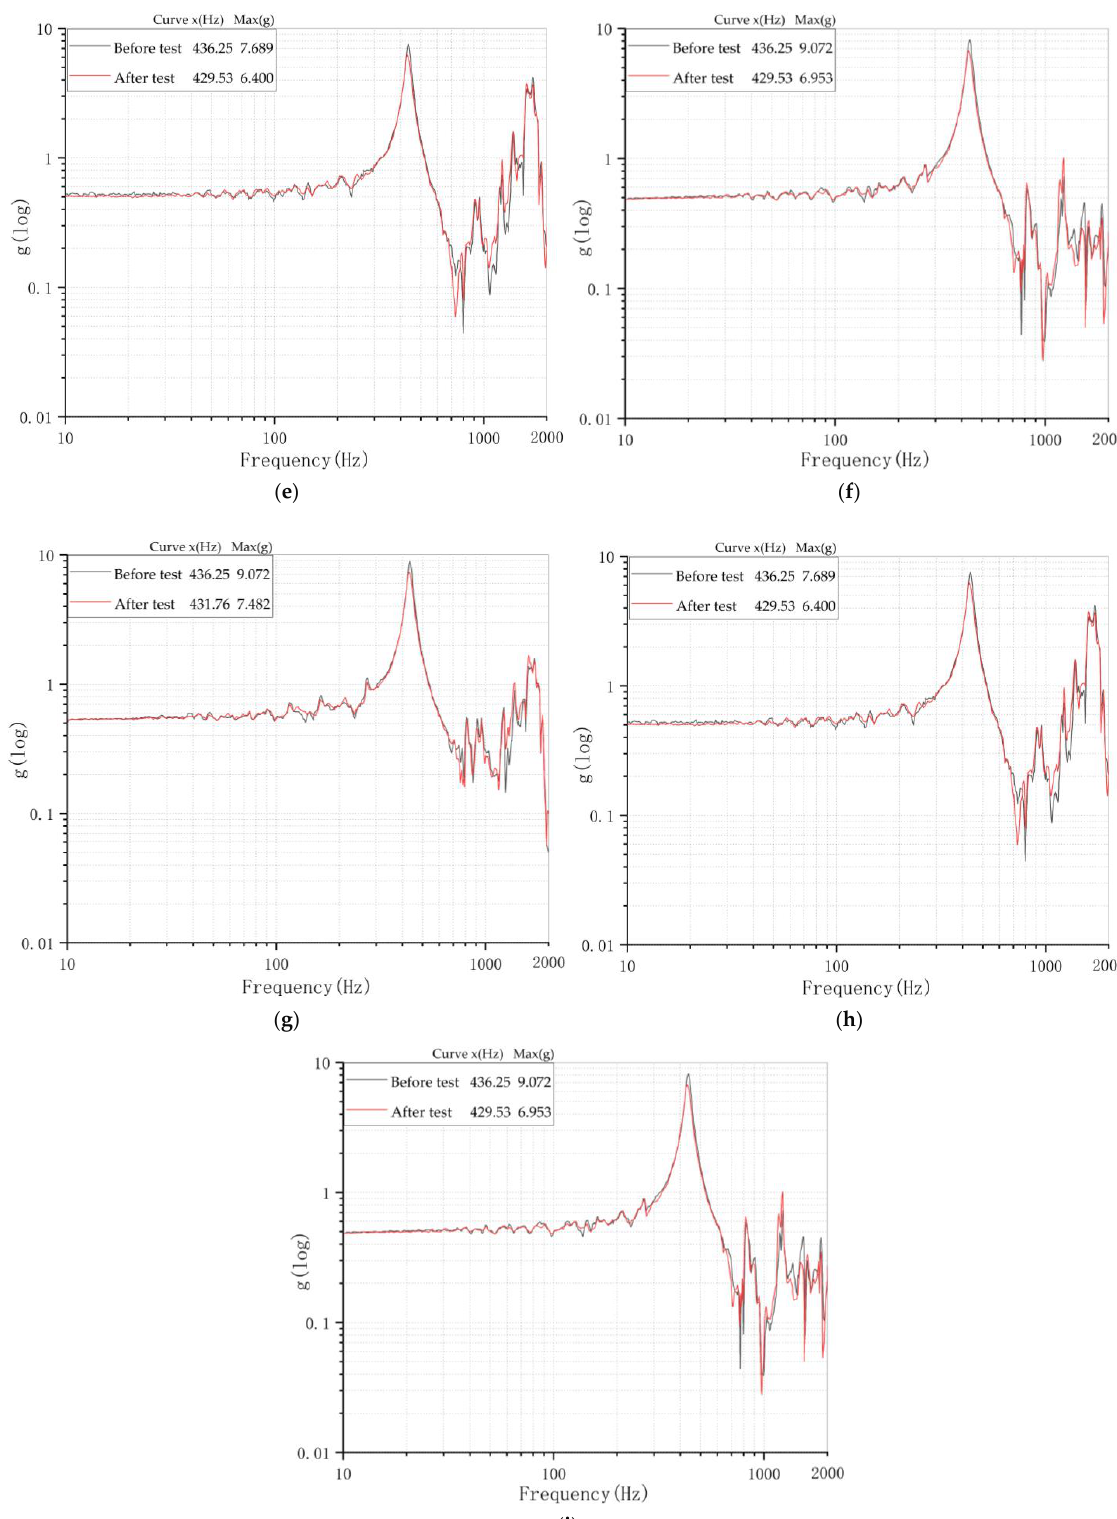
Figure 13. Sinusoidal characteristic sweep frequency map of measurement points before and after X, Y, Z random test: ( a ) Measurement point 1 in X-direction. ( b ) Measurement point 2 in X-direction. ( c ) Measurement point 3 in X-direction. ( d ) Measurement point 1 in Y-direction. ( e ) Measurement point 2 in Y-direction. ( f ) Measurement point 3 in Y-direction. ( g ) Measurement point 1 in Z-direction. ( h ) Measurement point 2 in Z-direction. ( i ) Measurement point 3 in Z-direction. From the sinusoidal characteristic sweep frequency curves before and after the ran- dom vibration test of measuring points in X, Y and Z directions in Figure 13, it can be concluded that the sweep frequency curves of each measuring point before and after the random vibration test coincide well. The frequency drift of the first order dominant fre- quency is less than 1.0% before and after the random vibration experiment at the X iden- tification level, while the same drift in Y direction is less than 2.0% and the drift in Z di- rection is less than 5.0%. The structure is therefore safe and meets the requirements under random excitation. 5. Discussion According to the dynamic simulation and experimental results, it can be concluded that the response of sinusoidal vibration is much smaller than that of random vibration. The reason is that the basic frequency of the structure calculated in Section 4.2.1 is 420.25 Hz, and the excitation condition of sinusoidal vibration is 5 – 100 Hz, which will not cause obvious resonance response. From this perspective, it seems that the sinusoidal vibration test is unnecessary. In fact, sinusoidal vibration test can be equivalent to a quasi-static inertial force process, simulating low frequency transient events.Sinusoidal vibration is the actual working state of satellite from ignition to orbit loading, especially in the atmos- phere. The structure must undergo the test of this working condition, otherwise it is im- possible to predict whether the structure or internal components will be damaged in this process. Because the integrity of sodium iodide crystal and structural adhesive in the novel GRM cannot be judged intuitively in the process of finite element analysis and mechanical vibration test. Therefore, before the mechanical test, the photomultiplier tube (PMT) is used to test the performance of the crystal package, as shown in Figure 14a. The energy spectrum before the test is shown in Figure 14b. Through the analysis of the data in the energy spectrum diagram, it is found that the half-peak width size meets the requirements of the DRO satellite file KSW-DRO-Q09-2021, indicating that the sodium iodide crystal has a good energy resolution for gamma rays. Then it is considered that there are no cracks or defects in the bonding site at this time. After the mechanical vibration test, PMT was